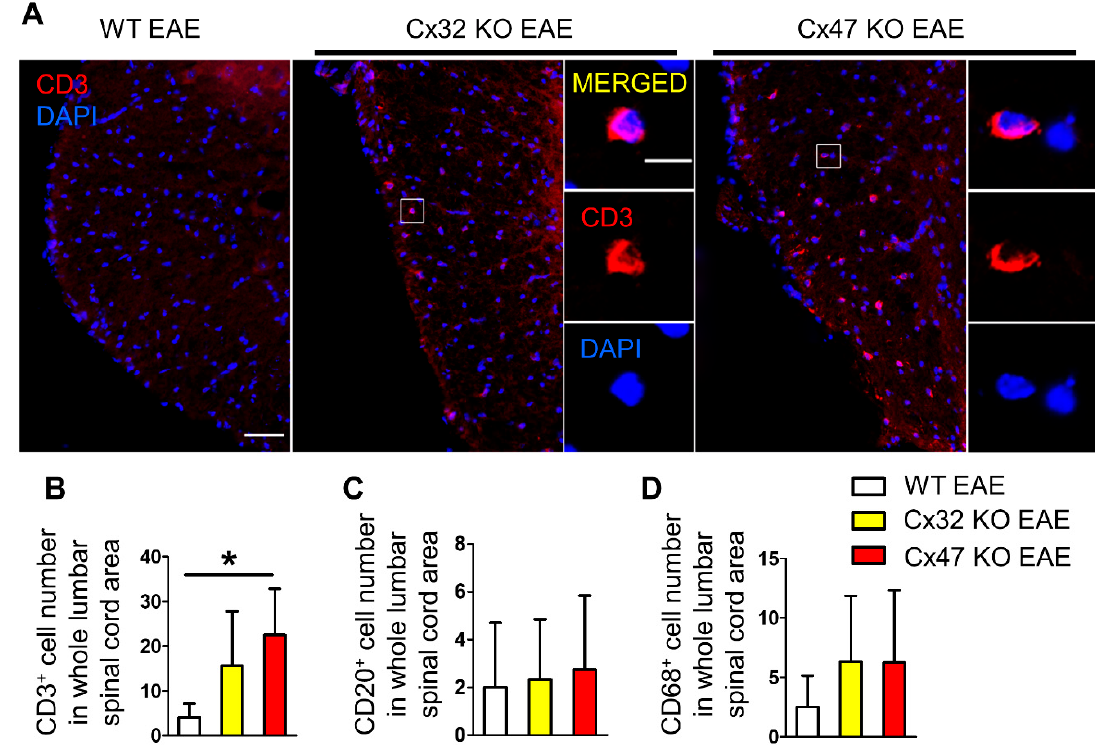
Figure 5. Assessment of CD3 + T-cell, CD20+ B-cell, and CD68+ macrophage infiltrates in the lumbar spinal cord of WT and Cx47 KO EAE mice at 7 dpi. ( A ) Representative immunofluorescence overview images of lumbar spinal cord cross sections from 7 dpi WT EAE, Cx32 KO EAE, and Cx47 KO EAE mice as indicated (all with a clinical score of 0), stained against the T-cell marker CD3 (red), and counterstained with DAPI (blue). Higher magnification single channels and overlap images from squared boxes are shown in insets on the right. Scale bars: in overviews = 50 μ m; in insets = 10 μ m. Counts of CD3 + T-cells ( B ), CD20+ B-cells ( C ), and CD68+ monocytes/macrophages ( D ) in the whole lumbar spinal cord area of n = 4 WT EAE, n = 3 Cx32 KO EAE, and n = 4 Cx47 KO EAE mice. Data are presented as mean ± SD. One-way ANOVA with post hoc Tukey’s HSD test: * p < 0.05.